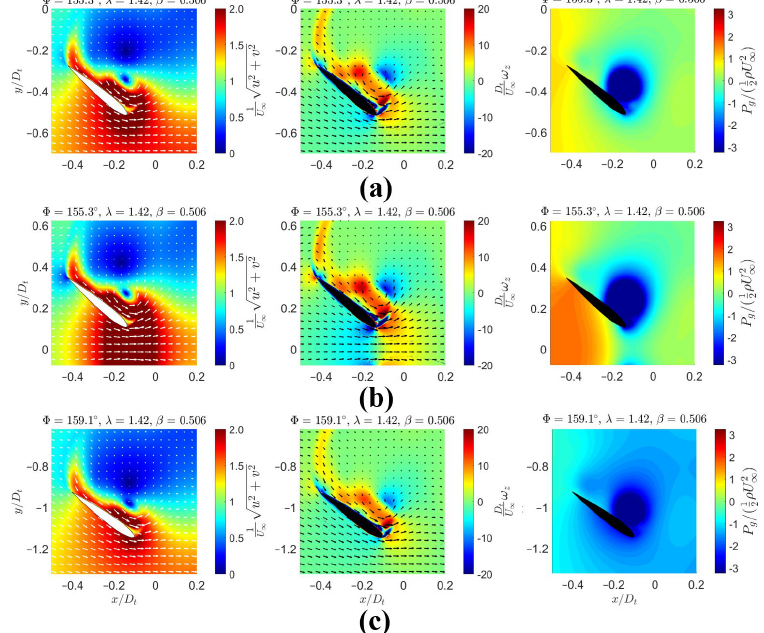
Figure 23. The velocity, vorticity, and pressure fields around one of the turbine blades after reaching its maximum torque angle of the 3 configurations: Single turbine ( a ), forward counter-rotating turbines ( b ), and backward counter-rotating turbines ( c